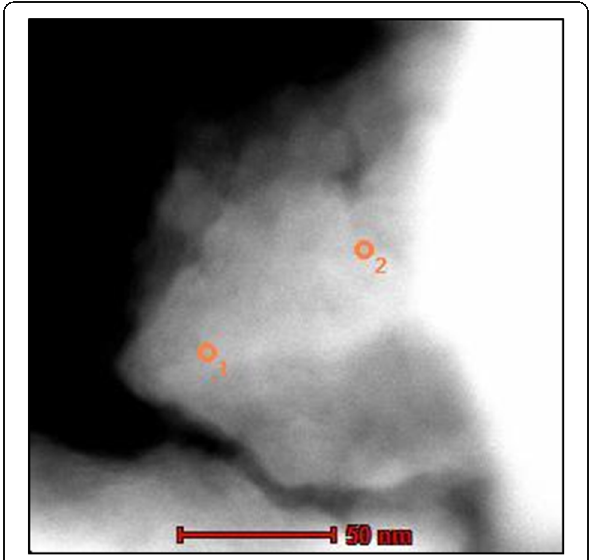
Fig. 9 STEM image of the CFTS sample showing the two positions where the EDX analysis was done